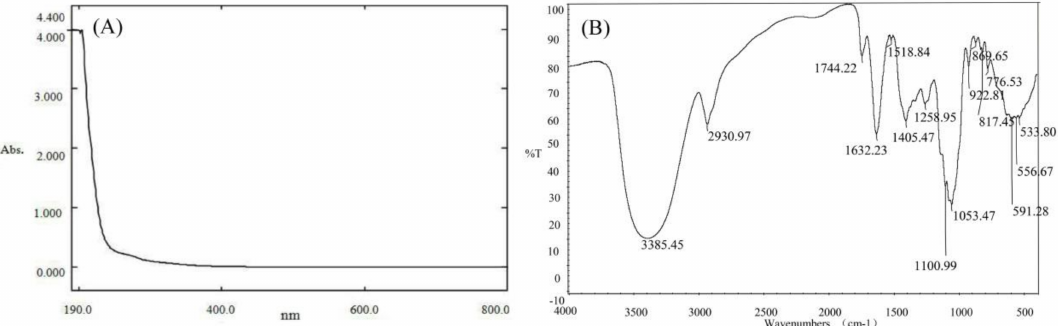
Figure 1. UV spectra of PPs in the range of 190–800 nm with a spectrum-2102 UV spectrophotometer ( A ) and FT-IR spectra of PPs in the wavenumber range of 4000–400 cm − 1 with a Fourier transformed infrared spectrophotometer using KBr pellet method ( B ).